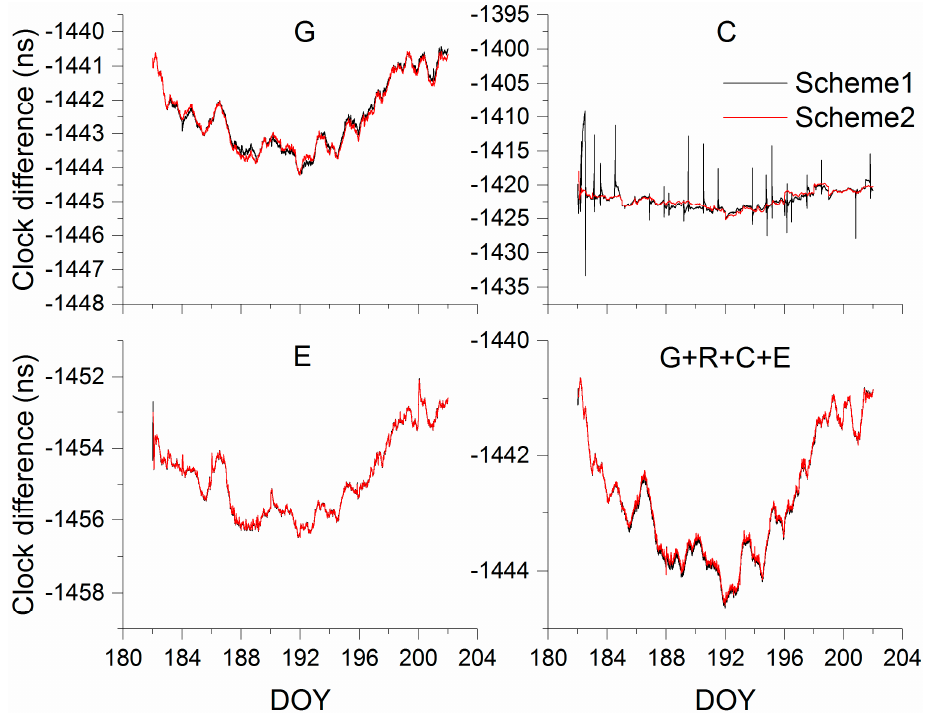
Figure 12. Clock differences of scheme1 and scheme2 with single-system and multi-GNSS models on BRUX-NTSC using COD products.